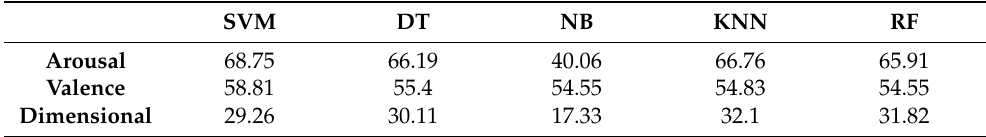
Table 5. Machine learning models’ performance for ECG.